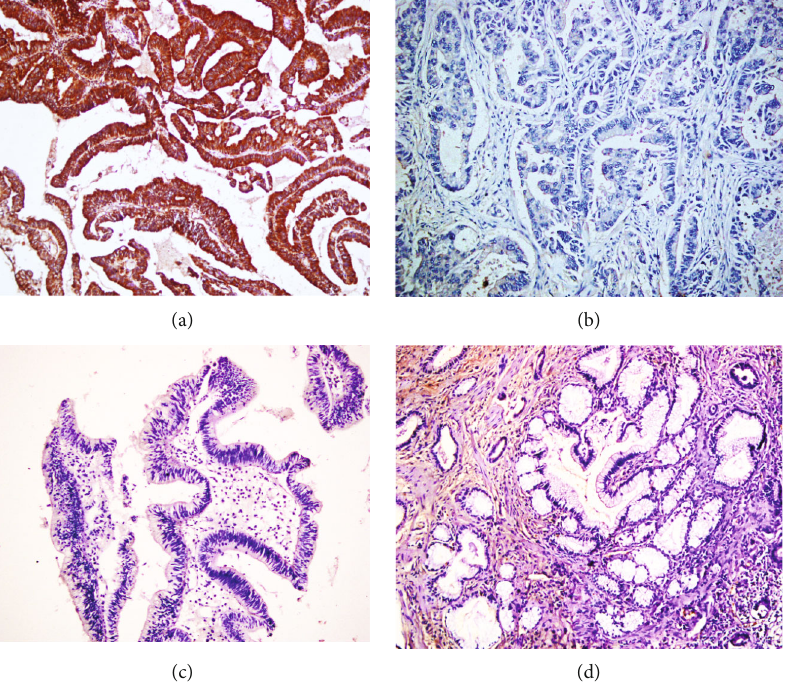
Figure 2: Immunohistochemical staining of DSG2, × 200. (a) Positive expression of DSG2, moderately di ff erentiated EHCC. (b) Negative expression of DSG2, well di ff erentiated EHCC. (c) Positive expression of DSG2, pericancerous tissues. (d) The positive expression of DSG2, adenoma. Table 2: Comparison of DSG1 and DSG2 expression in normal tissue, adenoma, peritumoral tissue, and EHCC.